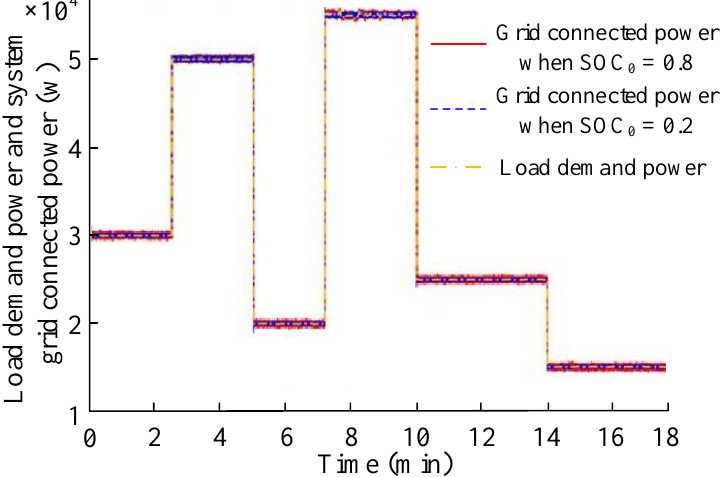
Figure 8. Load demand power and system grid connected power. The FC and EL power change curves in the whole simulation time period are